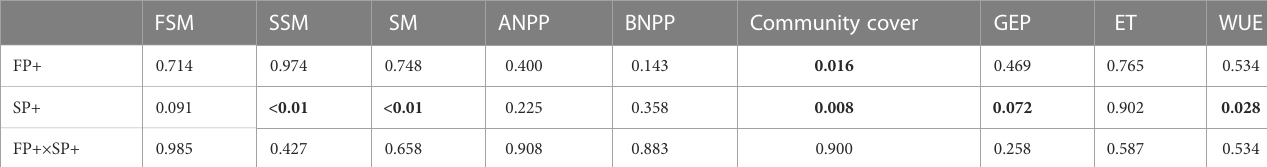
TABLE 1 Results ( P -values) of repeated measures of ANOVAs on the impacts of increasing fi rst half (April-June) and second half (July-September) of growing-season precipitation and their interactions on fi rst half of (FSM), second half of (SSM), entire (SM) growing-season soil moisture, ANPP, BNPP, plant community cover, GEP, ET, and WUE over the four